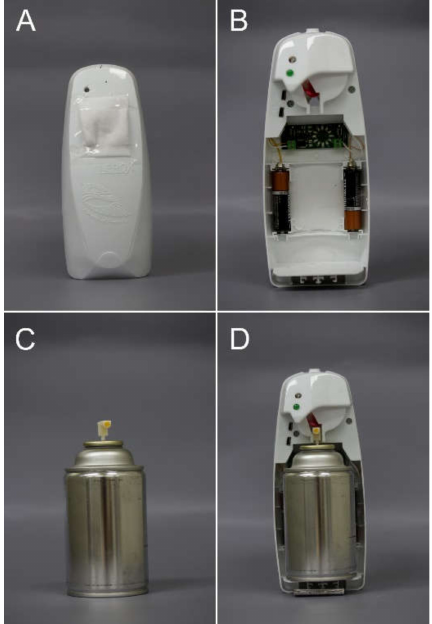
Figure 1. The spray devices used in the experiments. ( A ) The spray holder inside which the canister was fixed, ( B ) the spray holder with an electronic, controlled timer, ( C ) the canister, and ( D ) inside view of the spray device with the